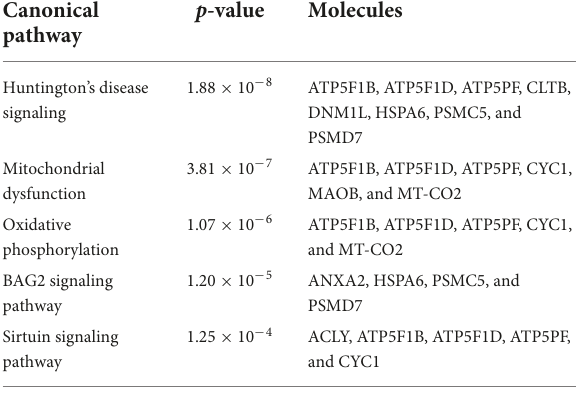
TABLE 3 List of top affected canonical pathways in both experimental groups.